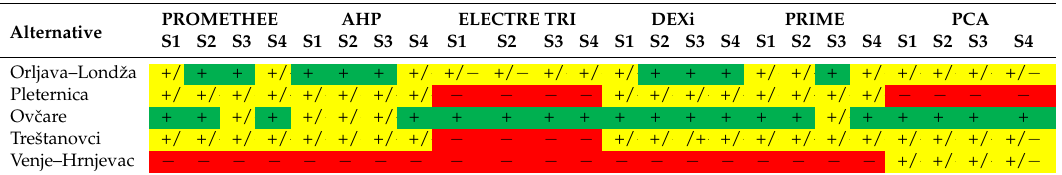
Table 11. Comparison of results from different MCA (multi-criteria analysis) methods for different criteria weight